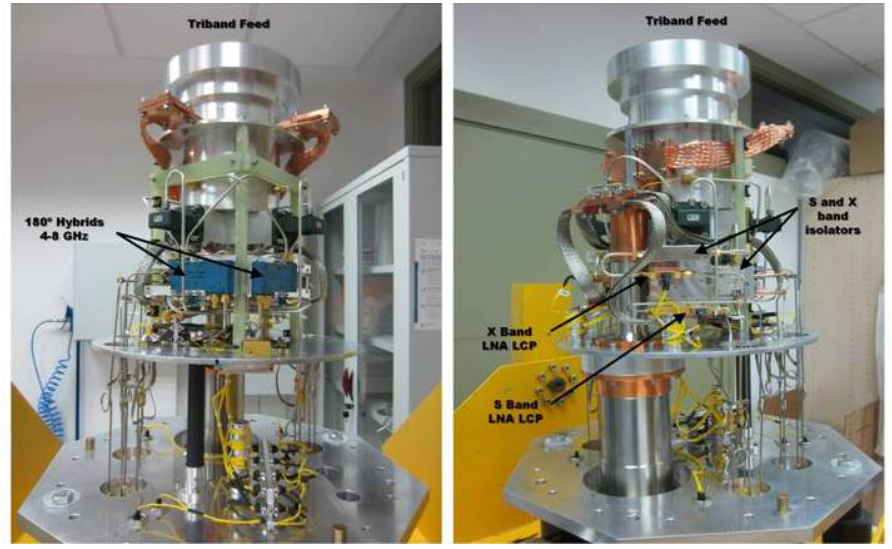
Figure 7. Receiver components inside de